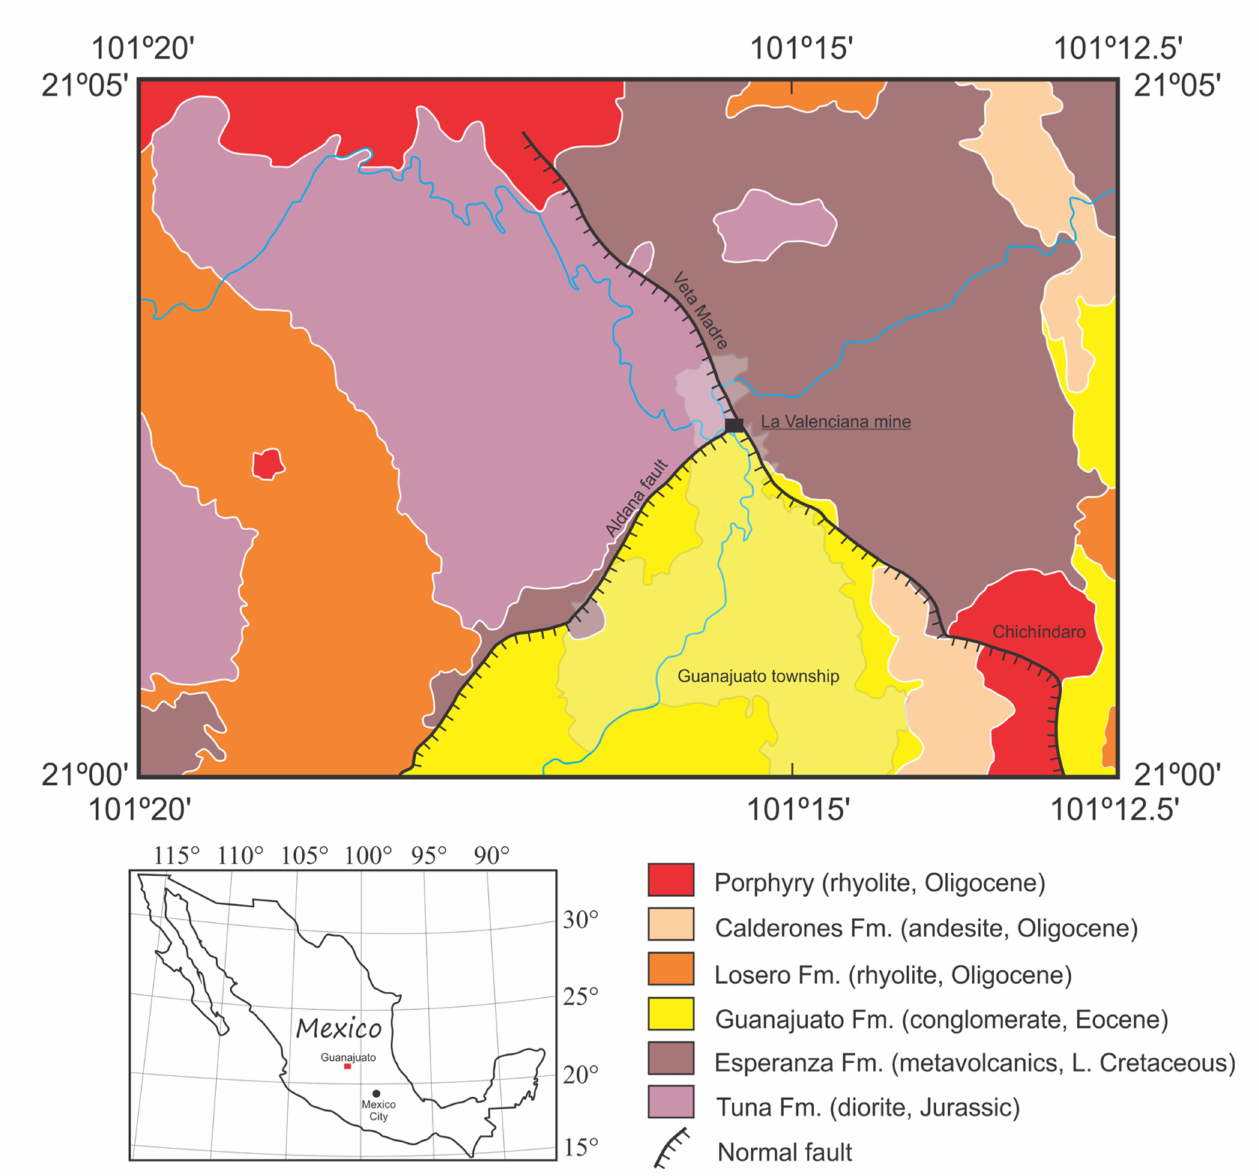
Figure 1. Geological map of the Guanajuato region showing the location of La Veta Madre and La Valenciana mine. Simplified from the Mexican Geological Survey cartography (Servicio Geol ó gico Mexicano, https://www.gob.mx/sgm (accessed on 10 March